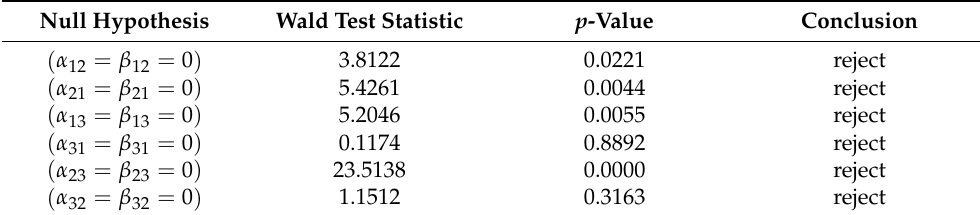
Table 14. Wald test of fluctuation spillover effect in the second